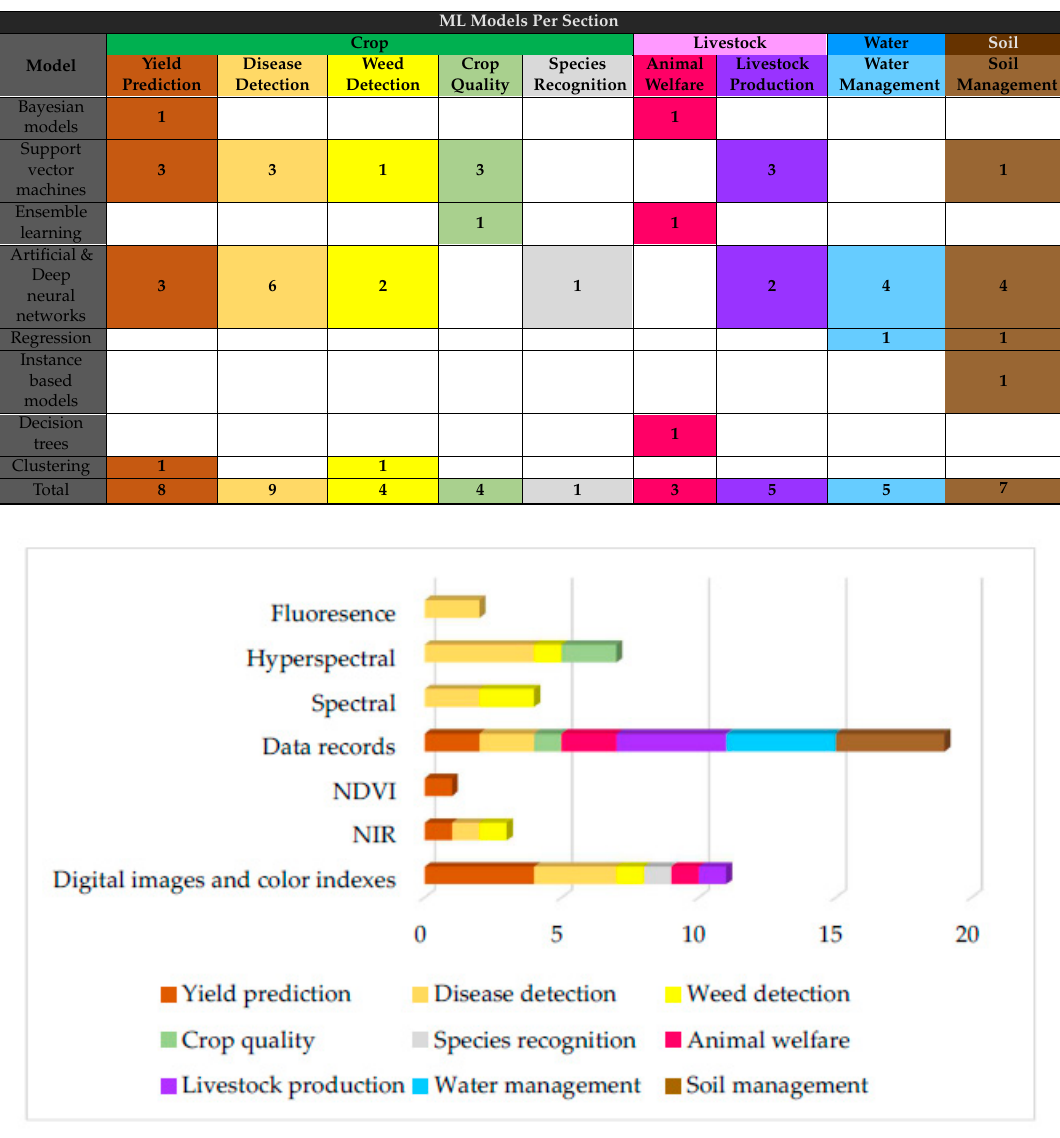
Table 14. The total number of ML models according to each sub-category of the four main categories.